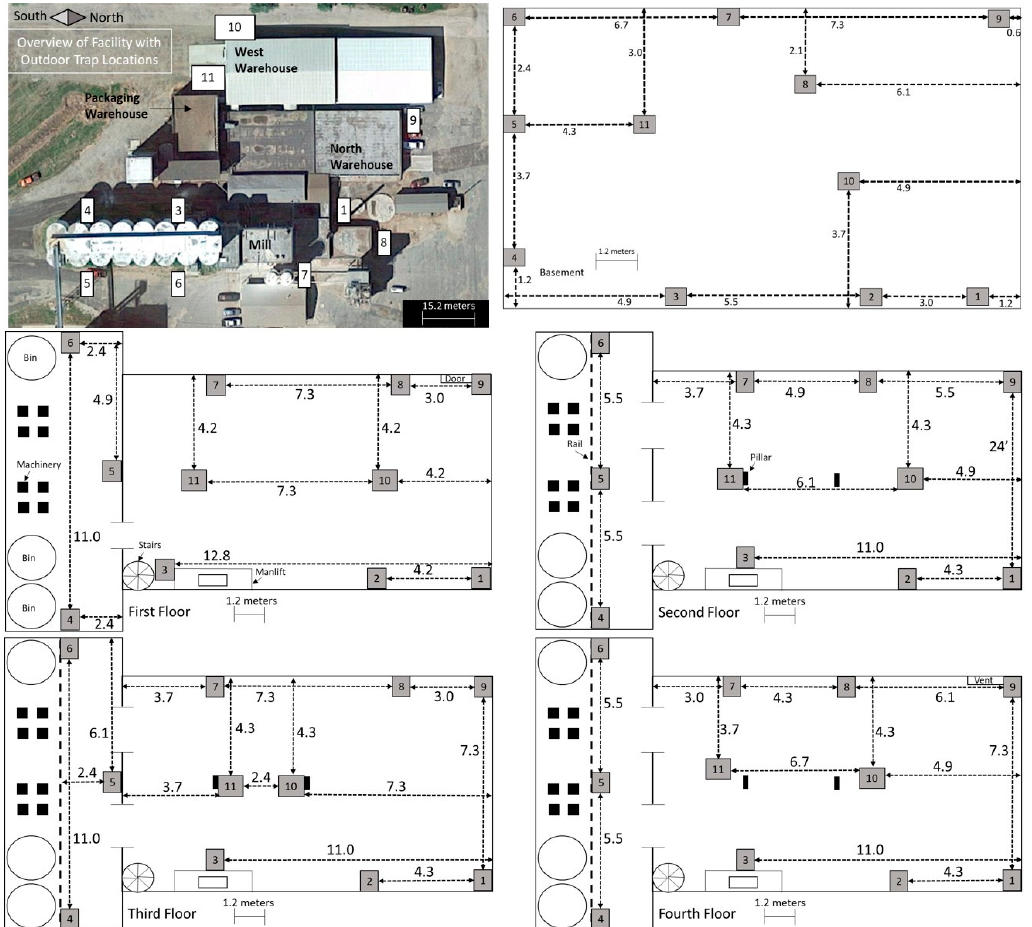
Figure 1. Diagrammatic layout of all outdoor and indoor trap locations for each floor. The cardinal direction key in the outdoor picture corresponds to the floor diagrams as well. Floor plans represent the basement and floors 1–4 of the mill. Machinery, bins, and pillars are indicated on the diagrams. Trap locations are indicated by numbers in white boxes (outside) and gray boxes (inside). Distances between traps and walls are indicated in meters, as is the scale key for each location. Traps in the warehouses are placed in each of the four corners and are not depicted on the diagrams.